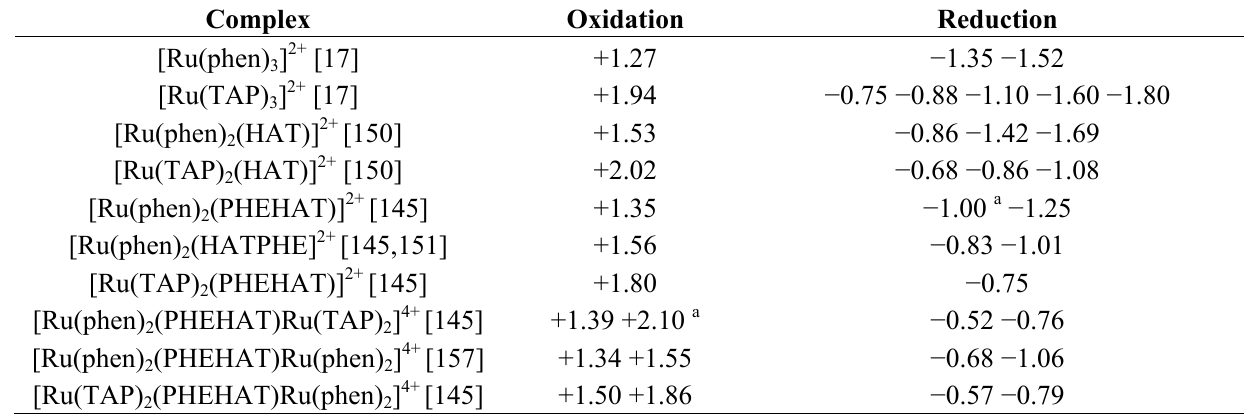
Table 7. Redox potentials E (V) vs. SCE for selected Ru II